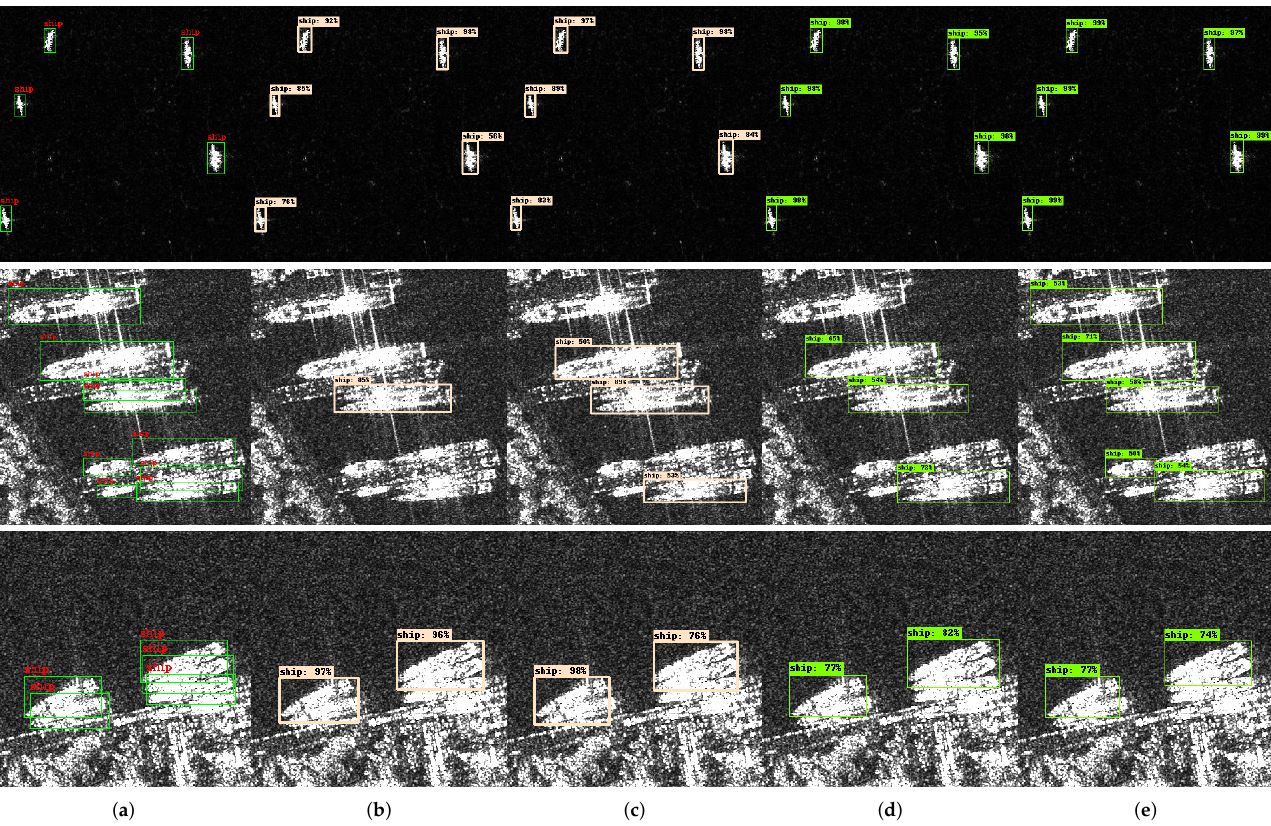
Figure 11. Ground truth and recognition results of some images. ( a ) Ground truth. ( b ) SSD. ( c ) SSD with BDAM. ( d ) RetinaNet. ( e ) RetinaNet with